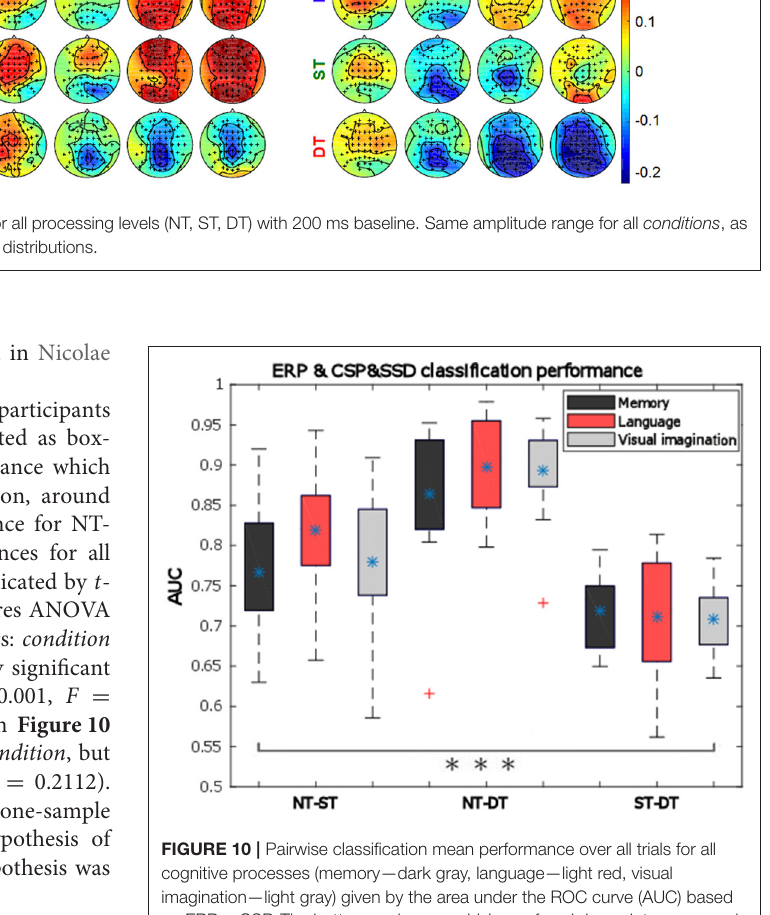
FIGURE 10 | Pairwise classification mean performance over all trials for all cognitive processes (memory—dark gray, language—light red, visual imagination—light gray) given by the area under the ROC curve (AUC) based on ERP-mCSP. The bottom and upper whiskers of each box-plot corresponds to the minimum and maximum values regarding all participants, the rectangular horizontal sides of the box represent the 25 and 75% percentiles of the data, the blue asterisk (*) represents the mean values, and red crosses indicates outliers. All pairs show statistically significant AUC, marked with three black asterisks (***) in the bar plot ( p <